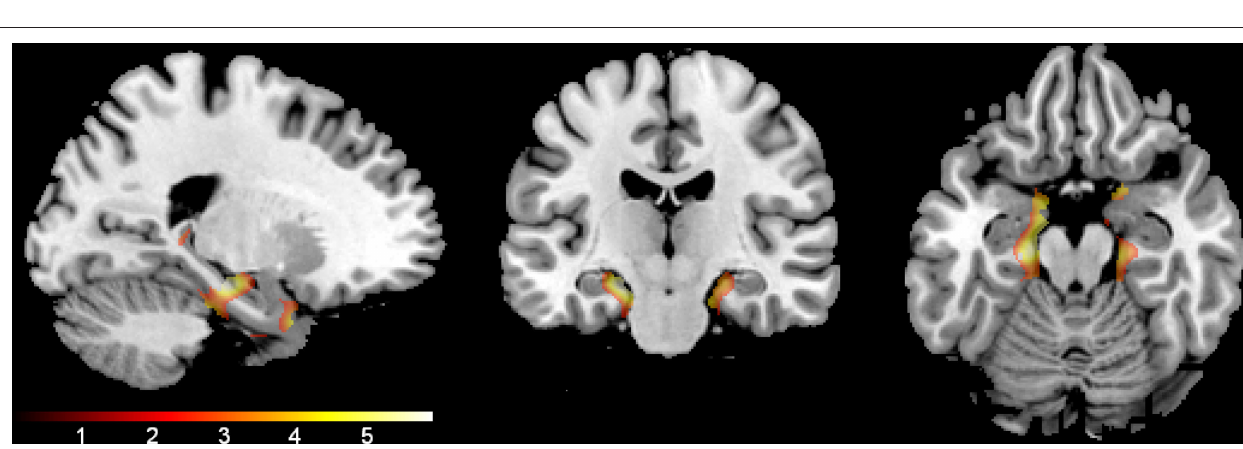
FIguRe 3 | group effect. A voxel-wise comparison of gray matter volume between NSAID users and non-user controls showed small regions of medial temporal lobe difference where non-users demonstrated smaller volume, including left hippocampus, and parahippocampal gyrus. The results below are confined by the inclusive region of interest mask, and a mask that excludes the significant interaction effect shown in Figure 1 . The color bar represents the height of the t -statistic.